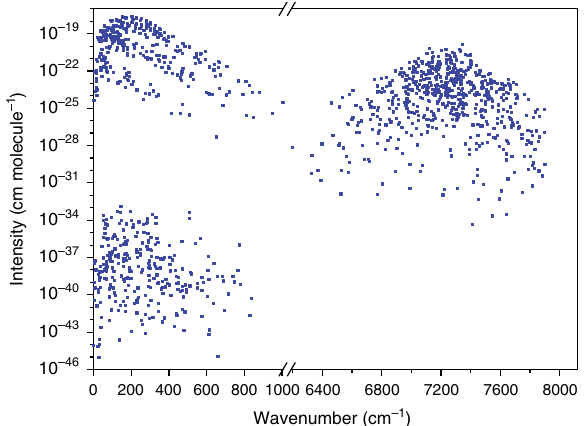
Fig. 8 High-accuracy linelist of H 2 16 O generated from paths of Figs. 2 and 3 (see also Supplementary Note 6). In addition to the transition wavenumbers, 296 K absorption intensities 64 are also presented on the vertical axis. The data points in the left lower quadrant correspond to low- intensity, vibration-mode-changing transitions. While the directly measured lines are constrained to the interval 7000 – 7350 cm − 1 , the predicted transitions resulting from lines of Figs. 2 and 3 extend between 0 – 1005 and 6198 – 8114cm − 1 . Source data are provided as a Source Data fi